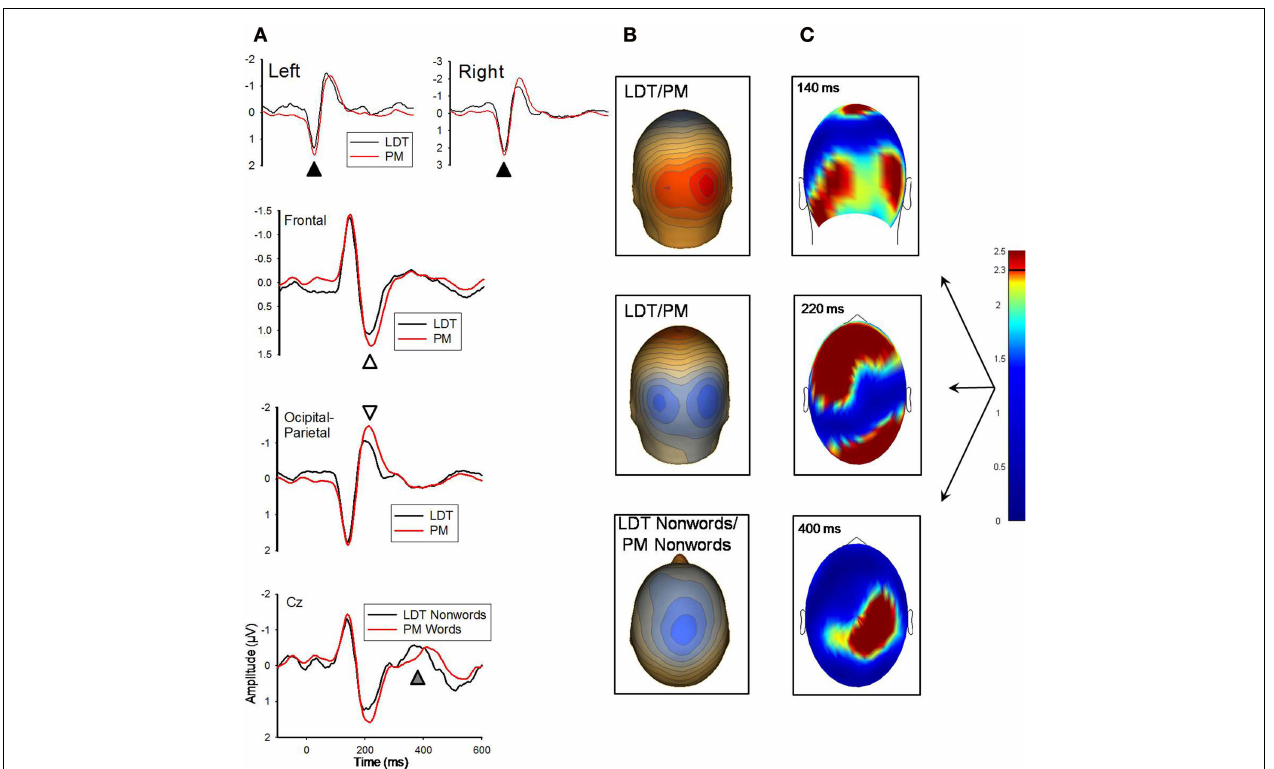
negative isopotential lines are in blue. Isopotential line scales are: 0.9 µV/step for 140 ms, 0.67 µV/step for 220 ms, and 0.32 µV/step for 400 ms components. Due to similarities in topographies between conditions, LDT-items and PM-items are averaged and presented on one voltage topography for the 140 and 220 ms effects, and LDT-nonwords and PM-nonwords are averaged and presented on one voltage topography for the 400 ms effect. (C) Plots of t -values (absolute value taken) over the head surface indicate the sensor clusters for which there were signifi cant effects between LDT-items and PM-items at peaks 140 and 220 ms post-stimulus, and between LDT-nonwords and PM-nonwords at 400 ms post-stimulus. The critical t -value ( t = 2.3281) is marked on the